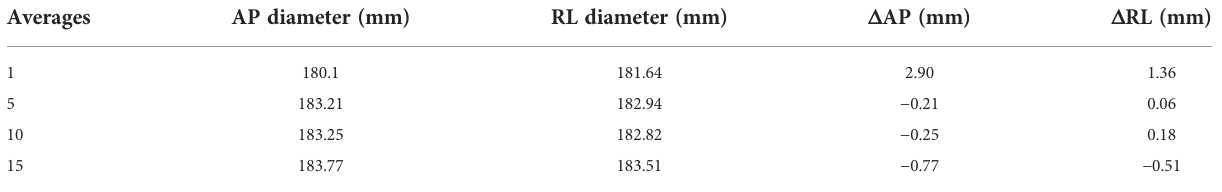
TABLE 3 Value of the diameter measurements in the two directions (AP second column and RL third column) expressed in millimetres.